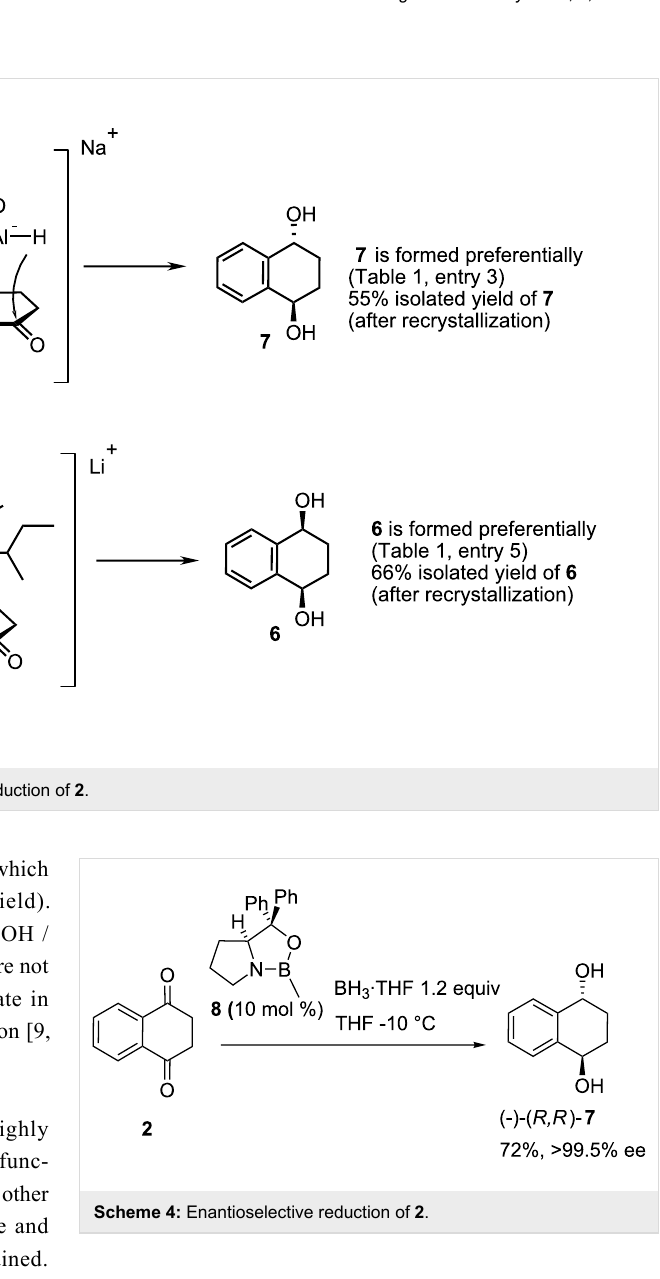
Scheme 4: Enantioselective reduction of 2